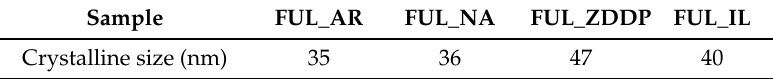
Table 1. Pd Crystalline Sizes for the three way catalysts (TWCs).